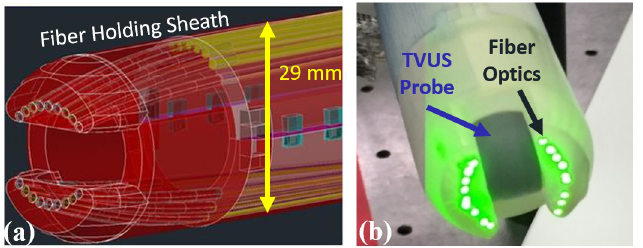
Fig 5. Transvaginal ultrasound and photoacoustic imaging system for future in-vivo studies. (a) Computer- assisted 3D design of the fiber-optical delivery system around a clinical transvaginal ultrasound transducer. (b) A photograph of the assembled combined photoacoustic (PA) and transvaginal ultrasound imaging transducer. This prototype can be a point-of-care device for the future clinical diagnoses by characterizing cervix status. The diameter of this prototype is 29 mm, which satisfies clinical